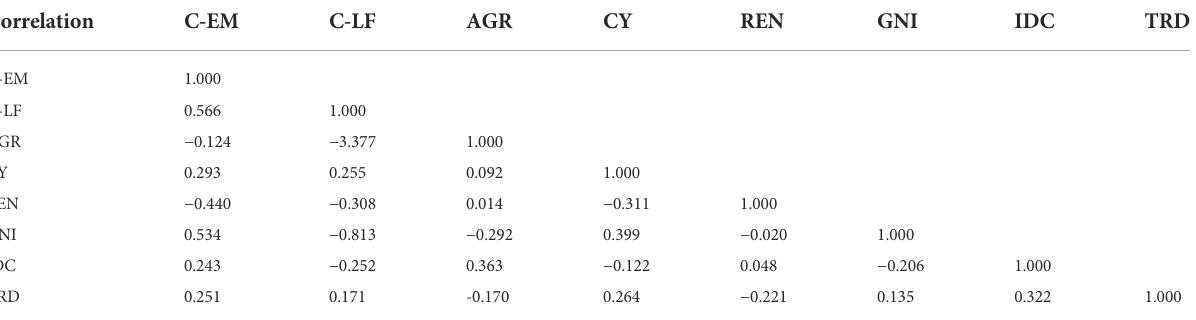
TABLE 3 Covariance